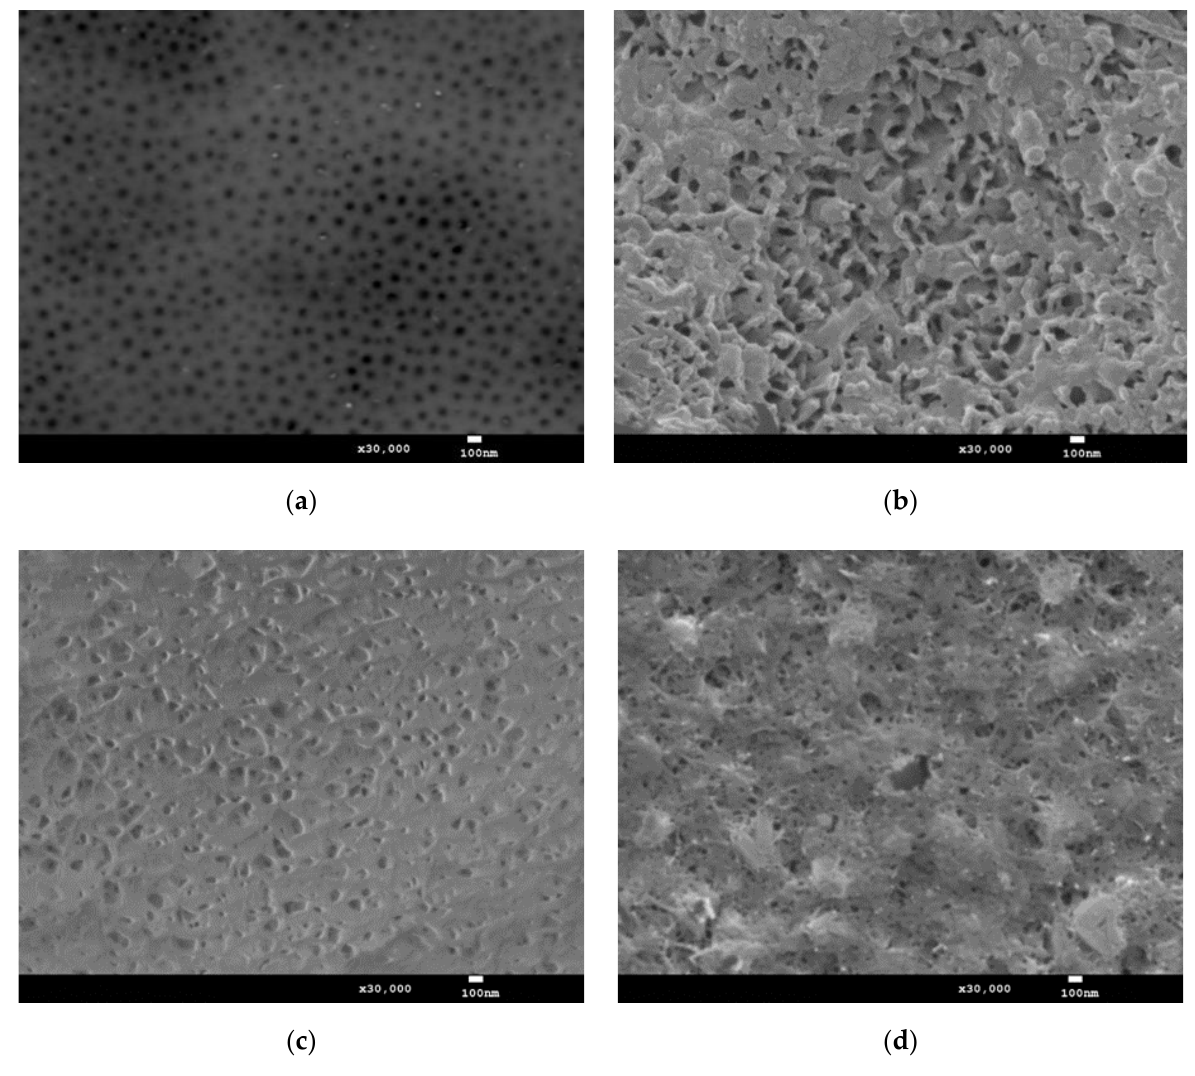
Figure 1. Surface morphology of layers: ( a ) Sample 1, ( b ) Sample 2, ( c ) Sample 3, ( d ) Sample 4.